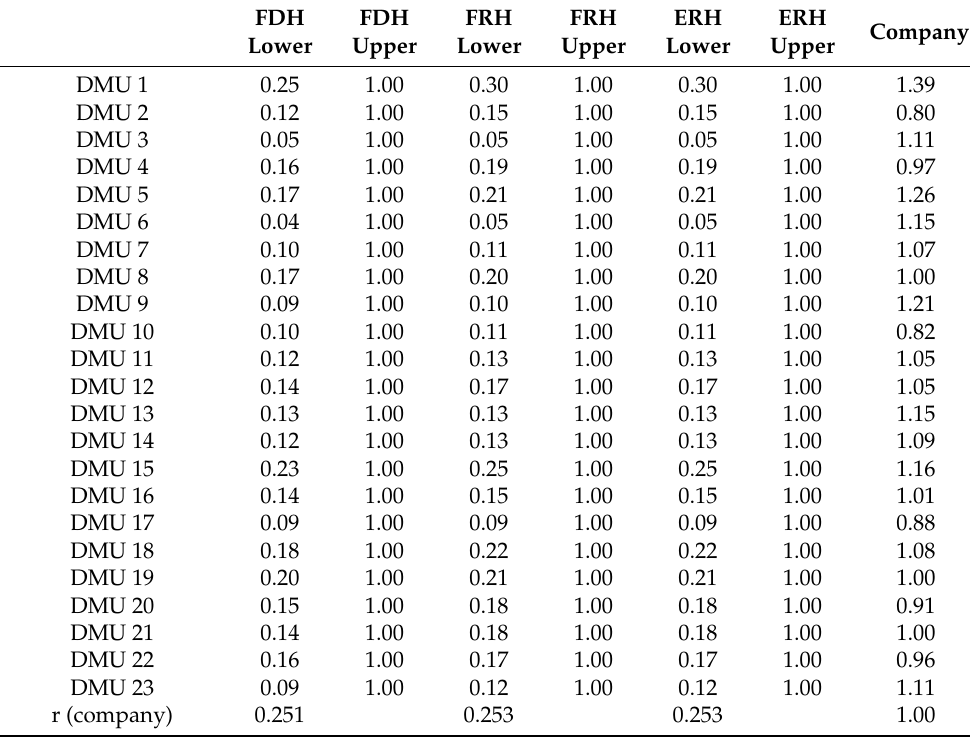
Table 3. Results of non-convex models and company